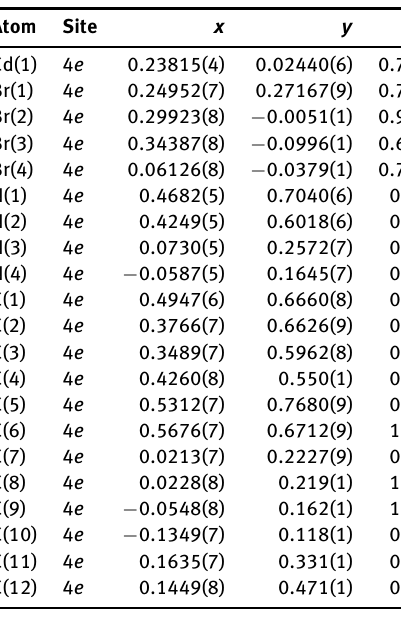
Table 3: Atomic displacement parameters (Å 2